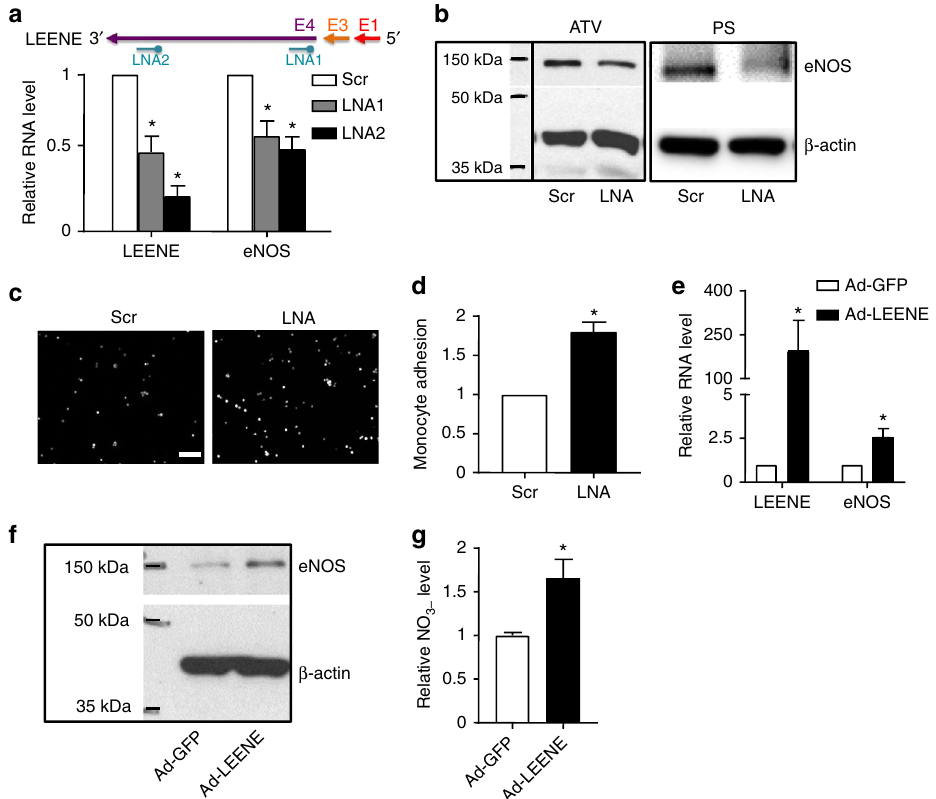
Fig. 5 LEENE RNA regulates eNOS expression and EC function. a – e HUVECs were transfected with LNA (50 nM) targeting Exon 4 of LEENE. Basal RNA levels of LEENE and eNOS were detected by qPCR in a . Protein levels of eNOS in HUVECs treated with ATV or PS were revealed by immunoblotting. c , d ECs were transfected with scramble or LEENE LNA before subjected to PS for 12 h. Fluorescence-labeled THP-1 cells were added to the EC monolayer, and the monocytes adhering to ECs were visualized by fl uorescence microscopy (scale bar = 100 μ m). The representative images are shown in c and the quanti fi cation based on fi ve randomly selected fi elds per group per experiment are shown in d . e – g HUVECs were infected with Ad-GFP or Ad-LEENE for 48 h. RNA levels of LEENE and eNOS were detected by qPCR ( e ), protein level of eNOS in HUVECs was revealed by immunoblotting ( f ), and NO production was measured by a fl uorometric assay ( g ). Densitometry analysis of immunoblotting shown in b and f was performed (Supplementary Fig. 9). Data are presented as mean ± SEM. n = 3 – 5 in each group. Student ’ s t test was used. * p < 0.05 compared to scrambled control or Ad-GFP in respective